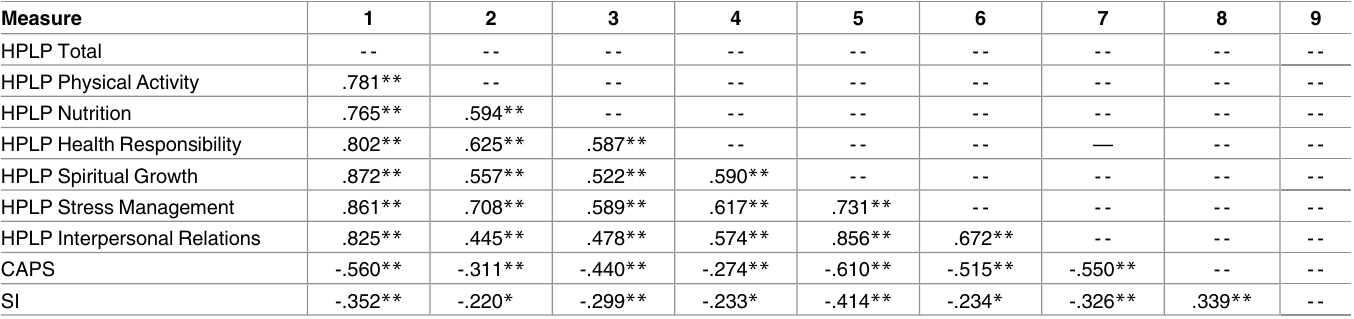
Table 2. Correlations Among Health Promoting Behaviors, PTSD, and Suicidal Ideation. Measure